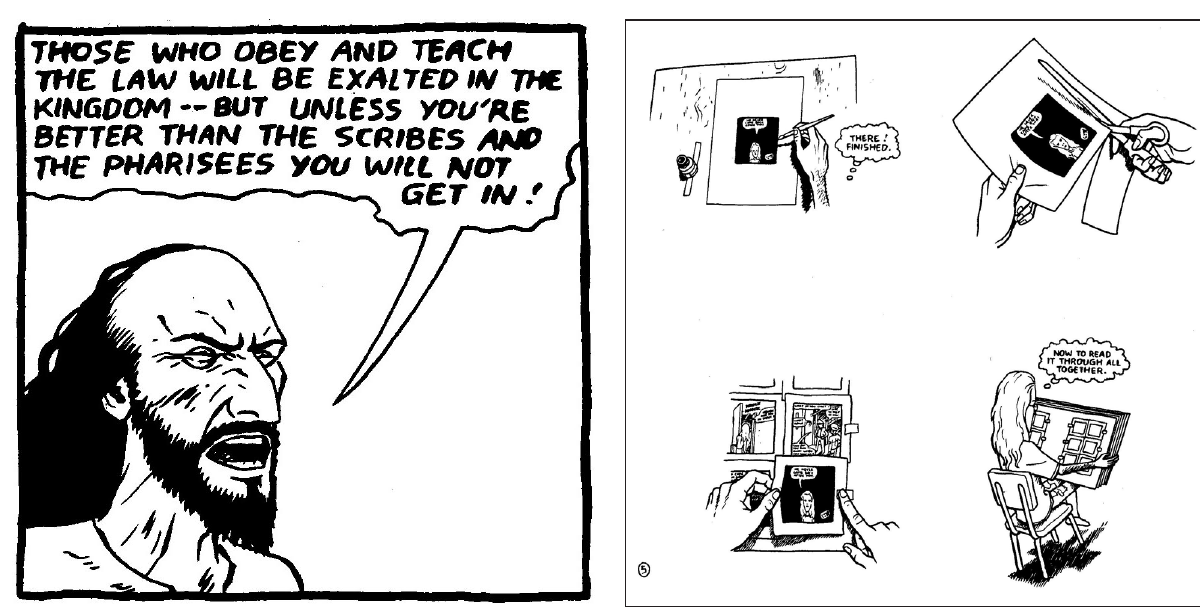
Fig. 2: Brown, Yummy Fur #21 (1990) 18/6. Fig. 3: Brown, Yummy Fur #20 (1990)